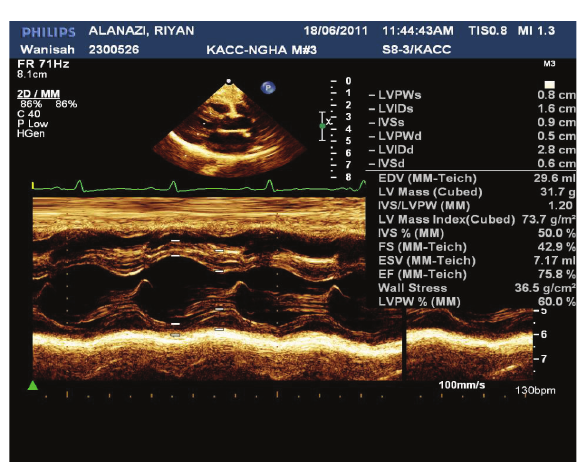
Figure 2: Echo for the patient showed improved myocardial function with ejection fraction 75.8%.